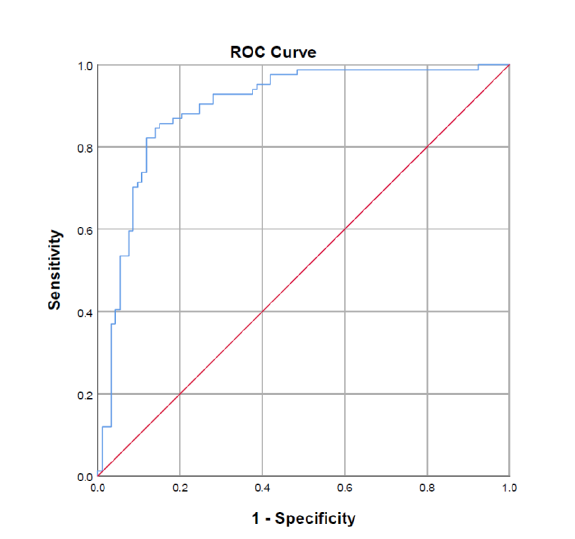
Table 2 . Results of SVR